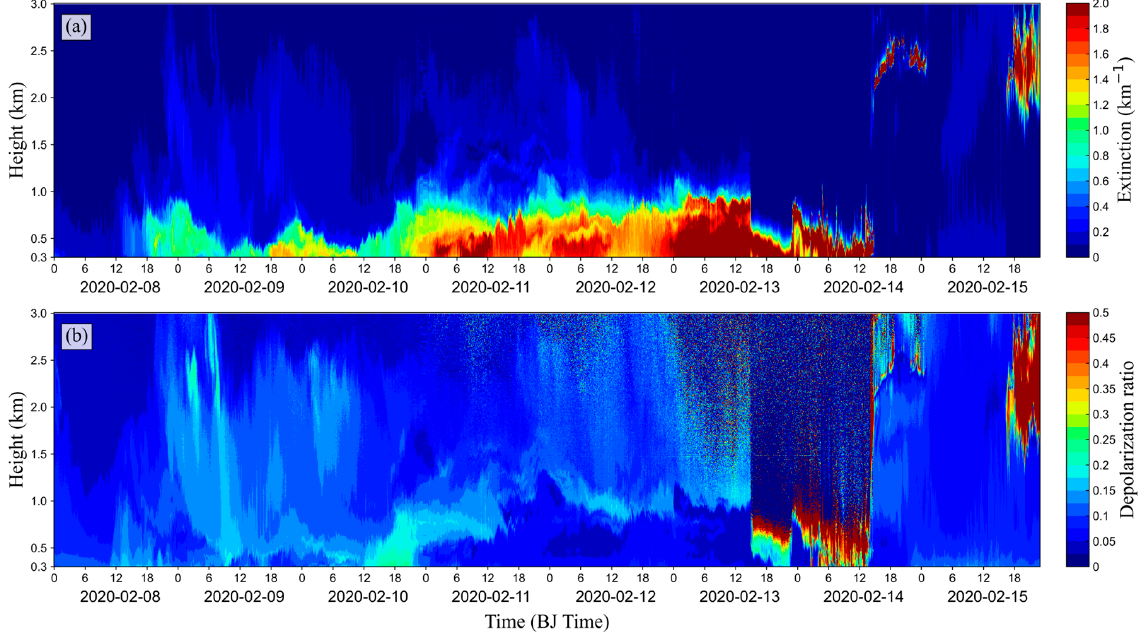
Figure 8. Spatial and temporal distribution of the extinction coefficient ( a ) and depolarization ratio ( b ) in urban Beijing from 8 to 15 February 2020.